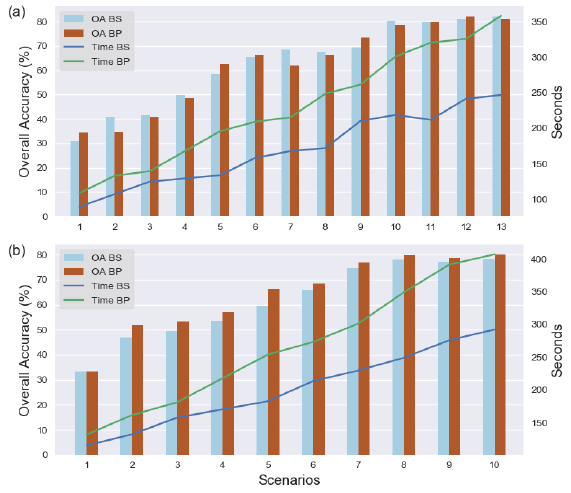
Figure 4. Overall Accuracy (OA) and processing time for LEM (a) and Campo Verde (b) tests sites: BS (Backscattering coefficients - σ 0 VH, σ 0 VV, and σ 0 VH/σ 0 VV) and BP (Backscattering coefficients + Polarimetric attributes - σ 0 VH, σ 0 VV, σ 0 VH/σ 0 VV, H and